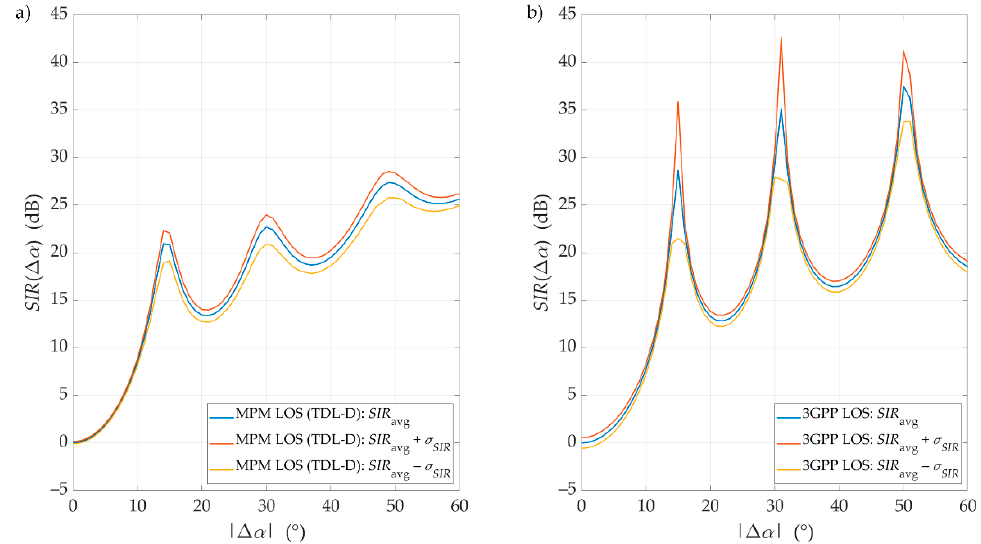
Figure 11. Exemplary SIRs with confidence intervals versus angle of beam separation for LOS conditions, D = 100 m, obtained for ( a ) the MPM and ( b ) the 3GPP model.